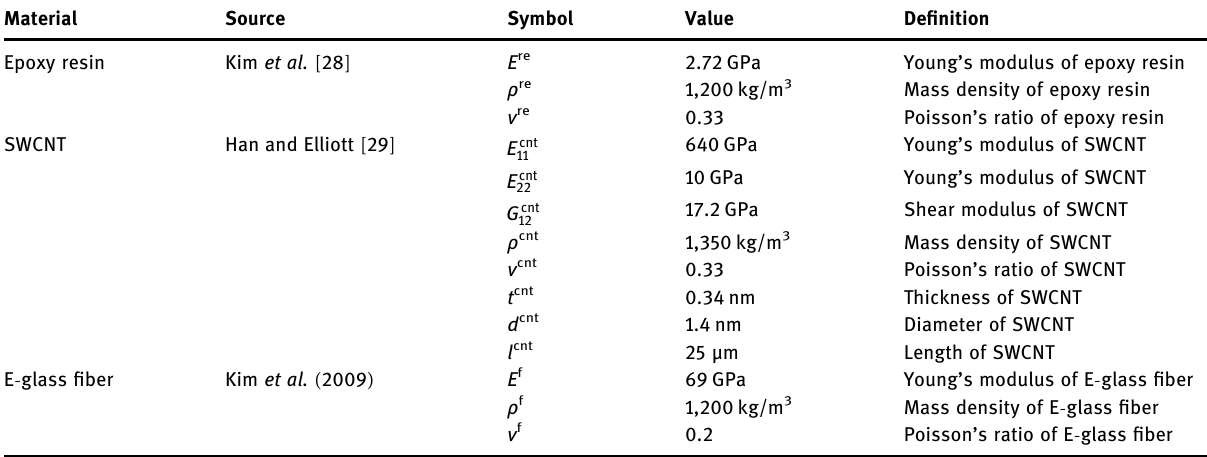
Table 4: Mechanical and geometrical properties of the materials used for CNTFPC